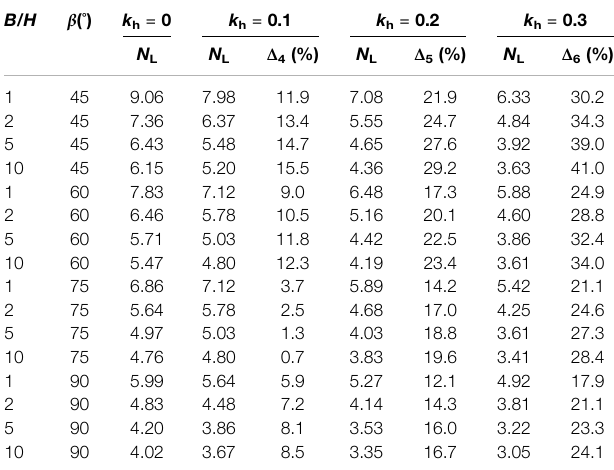
TABLE4| Effectsofthehorizontalseismiceffectcoef fi cient k h onstabilityfactor N L ( ζ (cid:1) 0). B/H β ( °